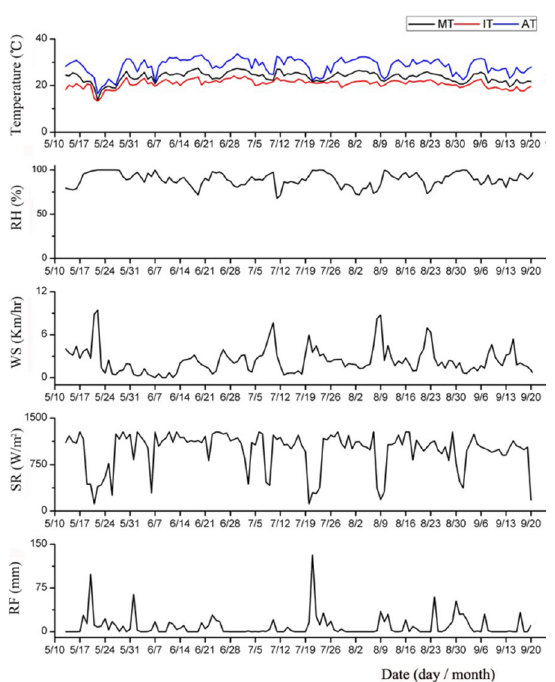
Figure 3. Data of the weather variables during 13 May to 20 September 2015. MT: mean temperature; IT: minimum temperature; AT: maximum temperature.